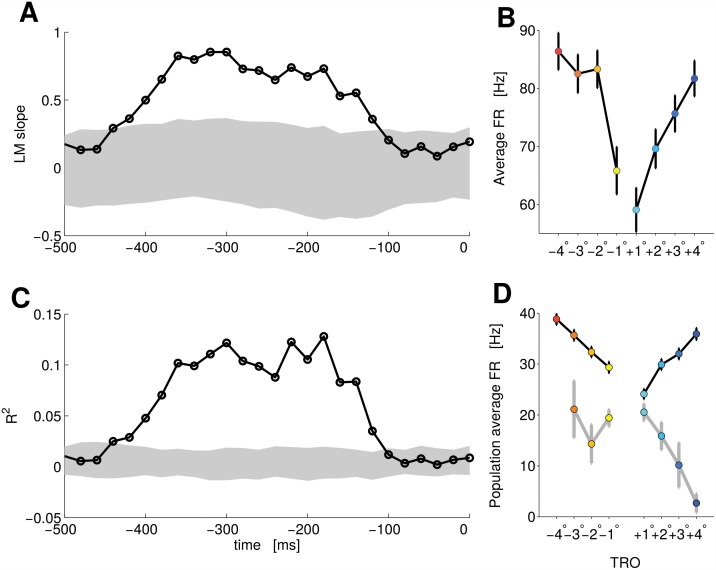
PMv single neuron and population activity correlating with the discriminability.Panel A: The time evolution of the LM
diff slope coefficient. Shaded area represents the 95% of the distribution of the slope under the null hypothesis (Monte Carlo random resampling, p < 0.05). Trials for this panel and panel D are aligned to the saccade; around −510 ms the second bar was shown. Panel B: Average FR as a function of TRO for the same neuron of panel A. The time average is taken during the time where the slope and the R2 are significant. Panel C: The time evolution of the R2 for the same single neuron. Shaded area represents the 95% of the distribution of the R2 under the null hypothesis (Monte Carlo random resampling, p < 0.05). Panel D: Average FR for the whole population (66 neurons) encoding difficulty (see text). Correct (black line) and error (gray line) trials are presented separately. The color code for the TRO is the same as Fig 1. Error bars of panels B and D represent SEM.